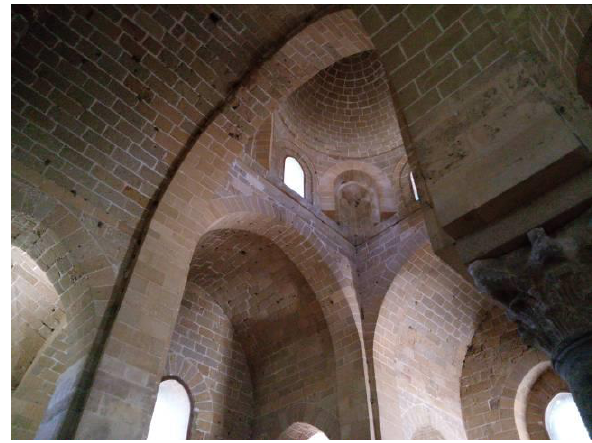
Figure 3. An internal view of the Trinity of Delia.